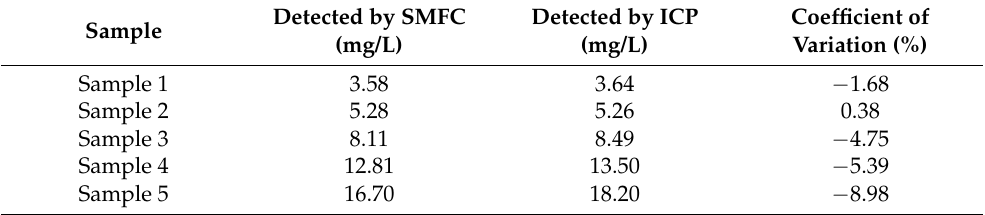
Figure 4. The calibration curves for Cd 2+ ( a ), Zn 2+ ( b ), Hg 2+ ( c ), or Pb 2+ ( d ) as detected by the developed SMFC-based sensing system. Table 2. Quantification of Pb 2+ in different lake water samples with SMFC sensing system and Table 1. Comparison of the analytical performance of representative MFC-based sensing systems reported recently.